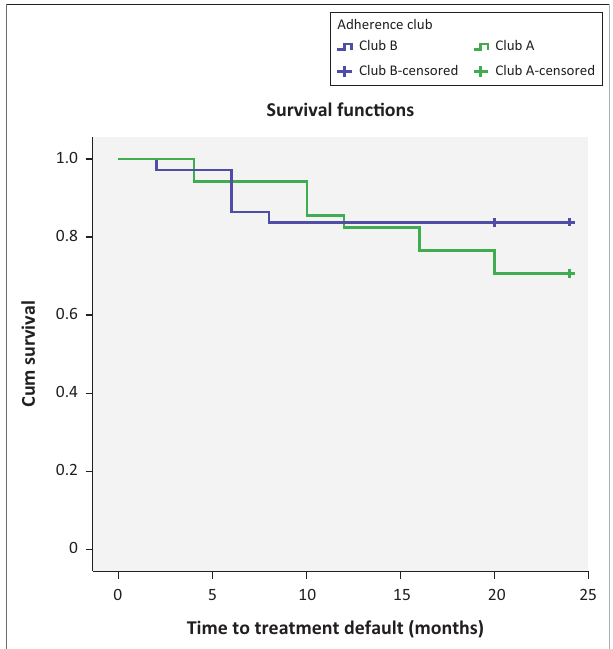
FIGURE 2: Survival distribution of patient retention in care in two adherence clubs at Facility Y.